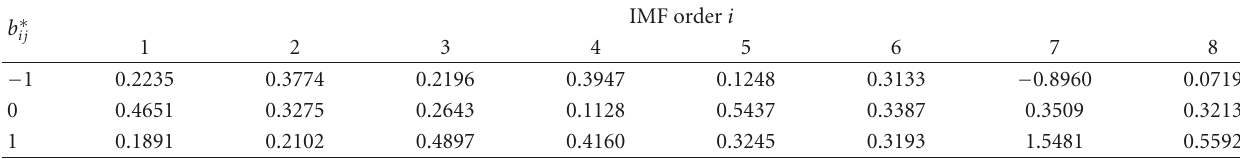
Table 3: Optimal coe ffi cients of the regularized BOSR algorithm ( M =